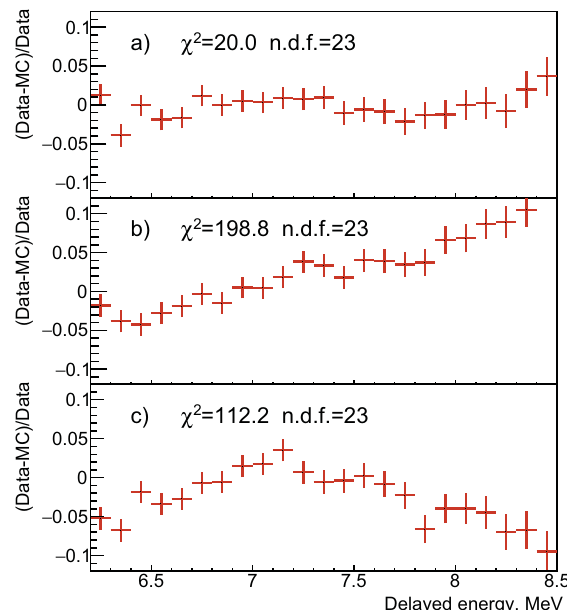
Figure 2. Ratio of the difference in MC predictions and data divided by the data for the neutron capture signal on Gd for: a) Nominal MC parameters; b) The MC energy scale increased by 1%; c) The MC energy resolution worsened by 5% of its nominal value. χ 2 values correspond to the deviations of the points from the zero line.